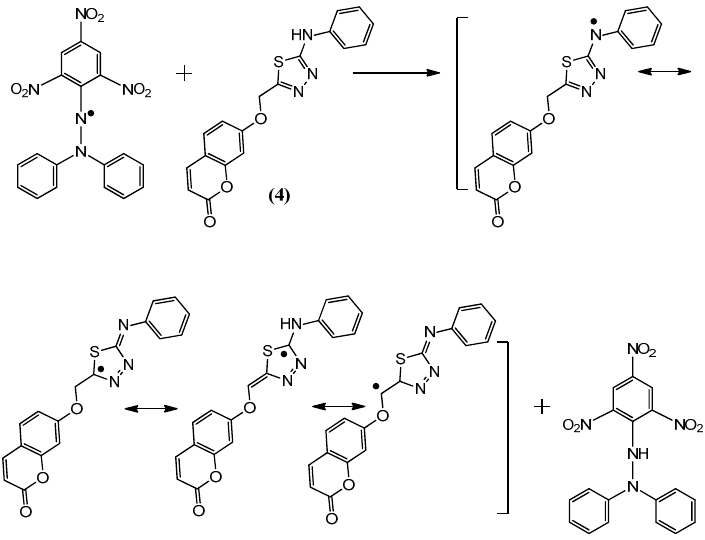
Figure 6. The reaction scheme between DPPH free radicals and compound 4 .